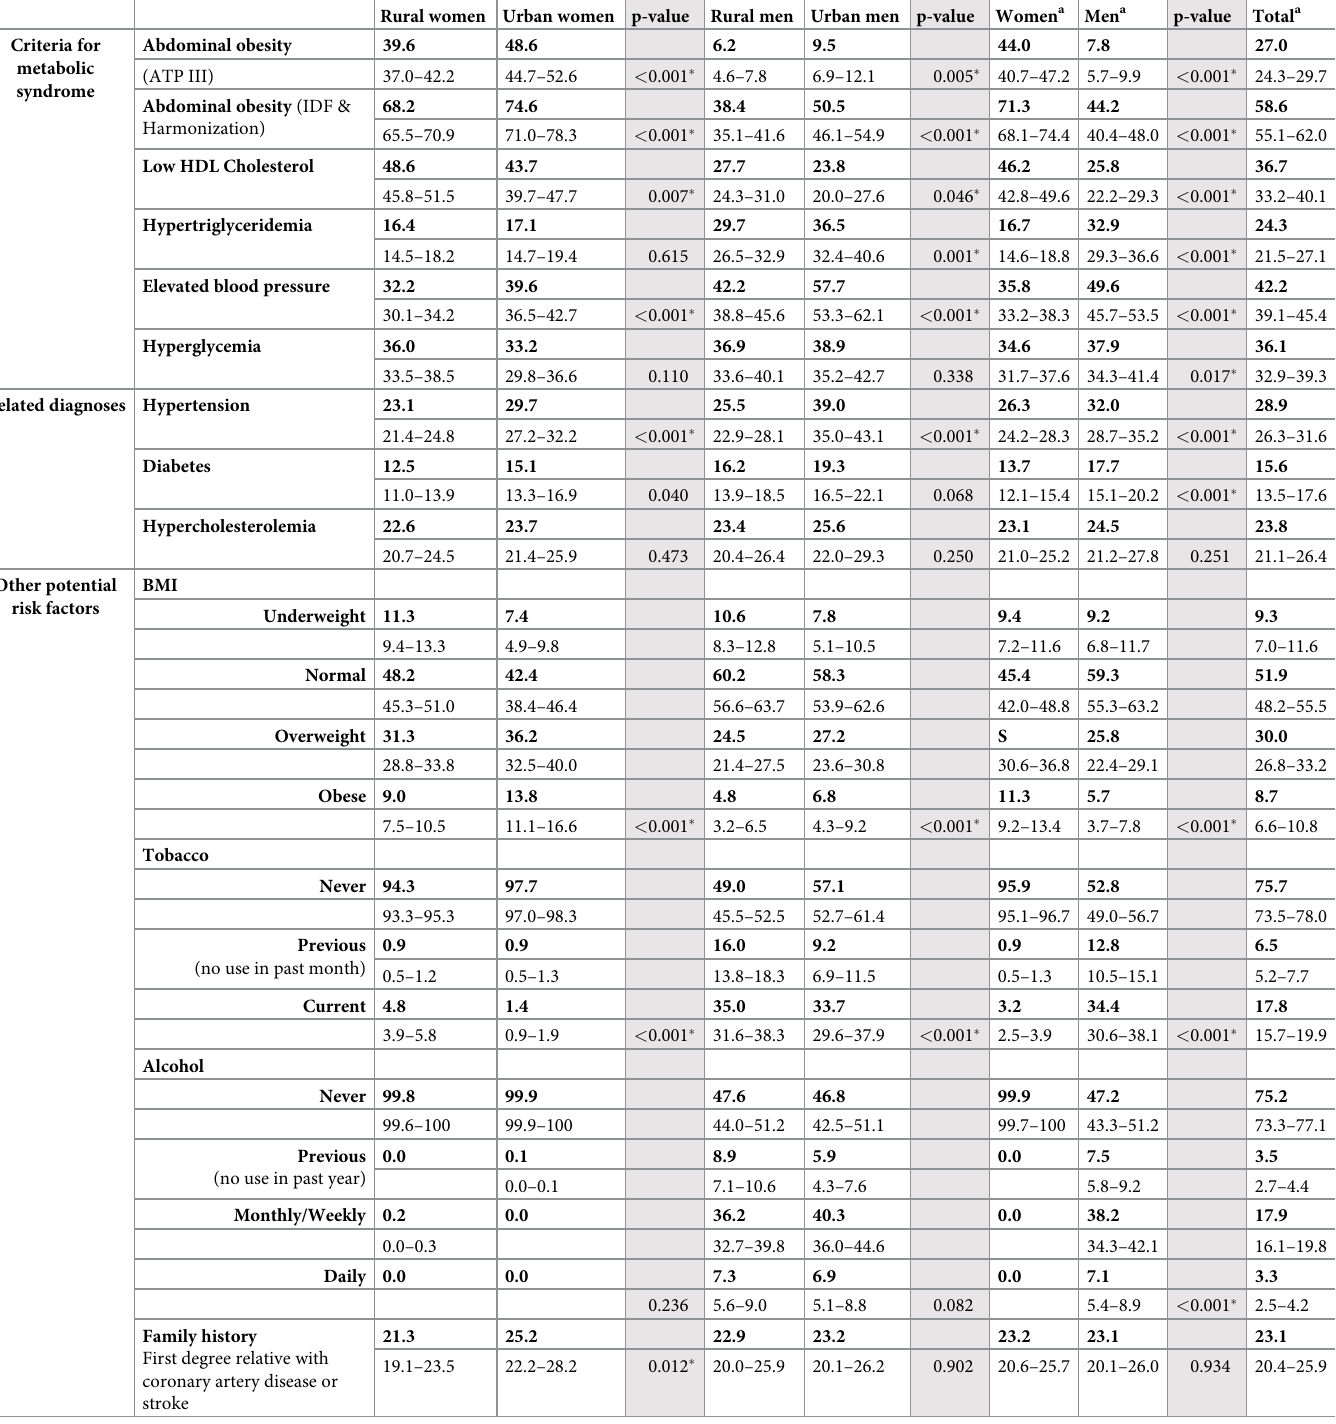
Table 4. Age standardized prevalence of individual criteria for metabolic syndrome, related diagnoses and other potential risk factors among study